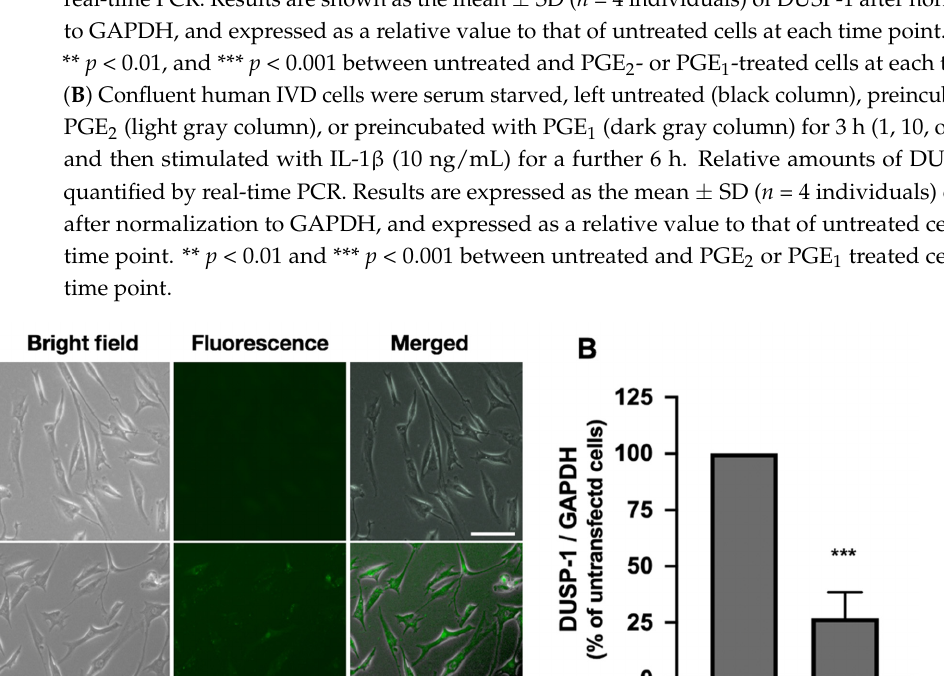
Figure 4. DUSP-1 knockdown by the transfection of small interfering RNA (siRNA) into human IVD cells. ( A ) Transfection efficiency of siRNA in human IVD cells. Semiconfluent human IVD cells were transfected with FITC-labeled siRNA oligonucleotides and cultured for 24 h. Cell images were captured by a digital fluorescence microscope. Transfection efficiency was more than 80% in three independent experiments ( n = 3 individuals). Scale bar: 100 μ m ( B ) DUSP-1 siRNA was transfected into semiconfluent human IVD cells to attenuate DUSP-1 expression. The relative amount of DUSP-1 expression was quantified by real-time PCR. Results are expressed as the mean ± SD ( n = 3 individuals) of DUSP-1 after normalization to that of GAPDH, and expressed as a relative value to that of untransfected cells. DUSP-1 expression was significantly suppressed by more than 70%. *** p < 0.001 vs. untransfected